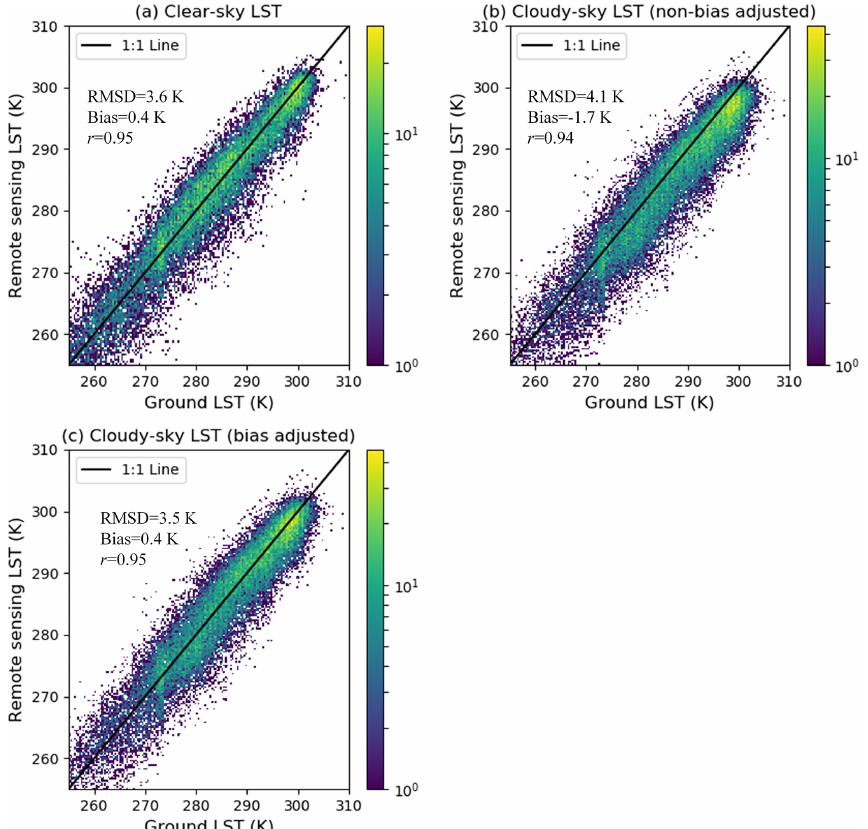
Figure B1. Validation of the clear-sky LST (a) , reconstructed LST under cloudy conditions but with no passive-microwave-based bias adjustment (b) , and the reconstructed LST under cloudy conditions with passive-microwave-based bias adjustment (c) based on the 0cm ground temperature measurements at meteorological stations.